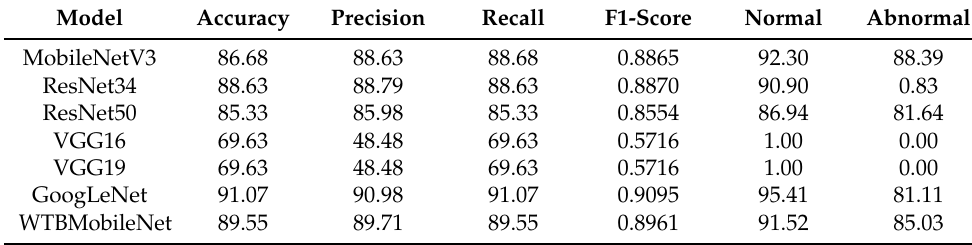
Table 9. Performance of baseline comparison on image